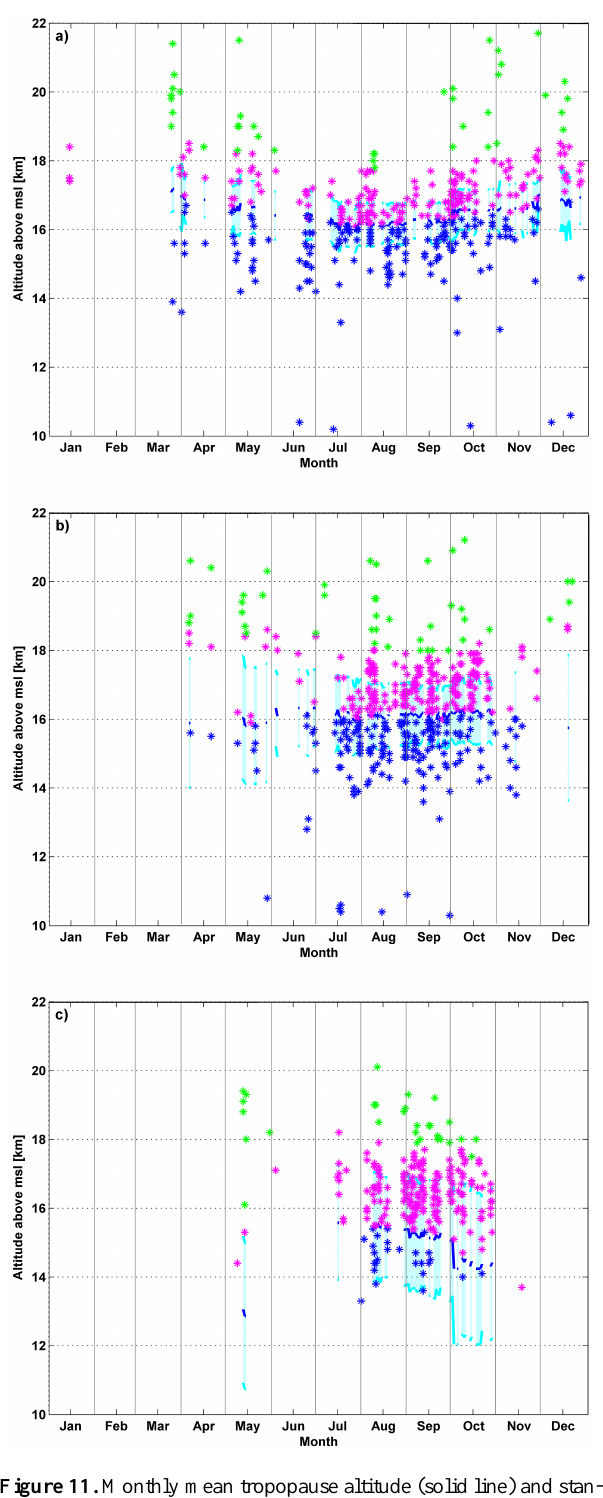
Figure 11. Monthly mean tropopause altitude (solid line) and stan- dard deviation (light-blue shaded area) for different latitude zones (a) 0–20 ◦ , (b) 20–30 ◦ and (c) 30–40 ◦ in the western Pacific Ocean basin. The stars denote the storm cloud top altitudes below the mean tropopause (blue), above the tropopause (magenta) and for over- shooting according to Eq. (2) (magenta with white background) and overshooting according to Eq. (3) (green),